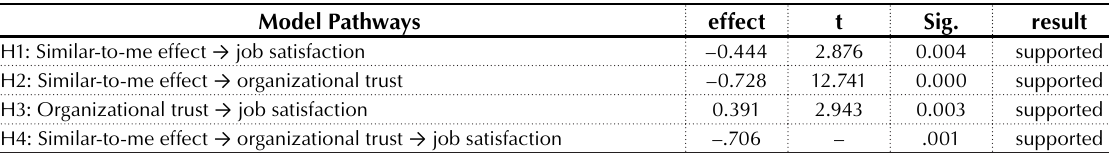
Table 3. Summary of path